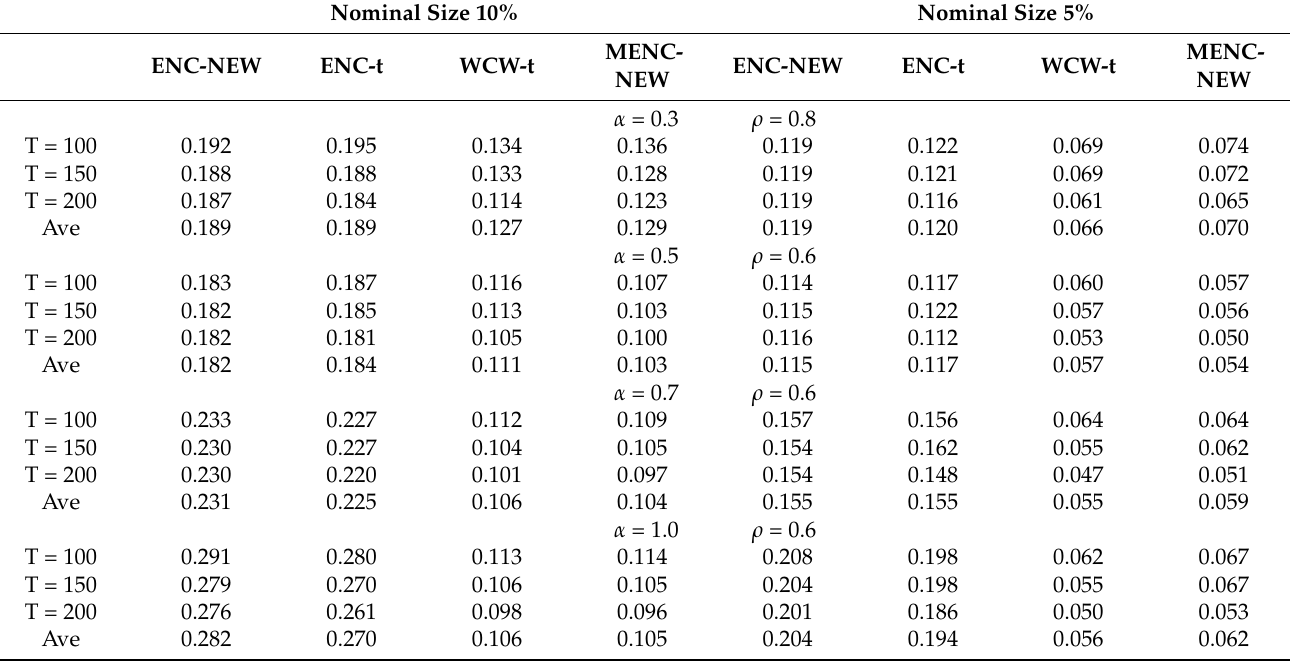
Table 1. Empirical Size with P/R =